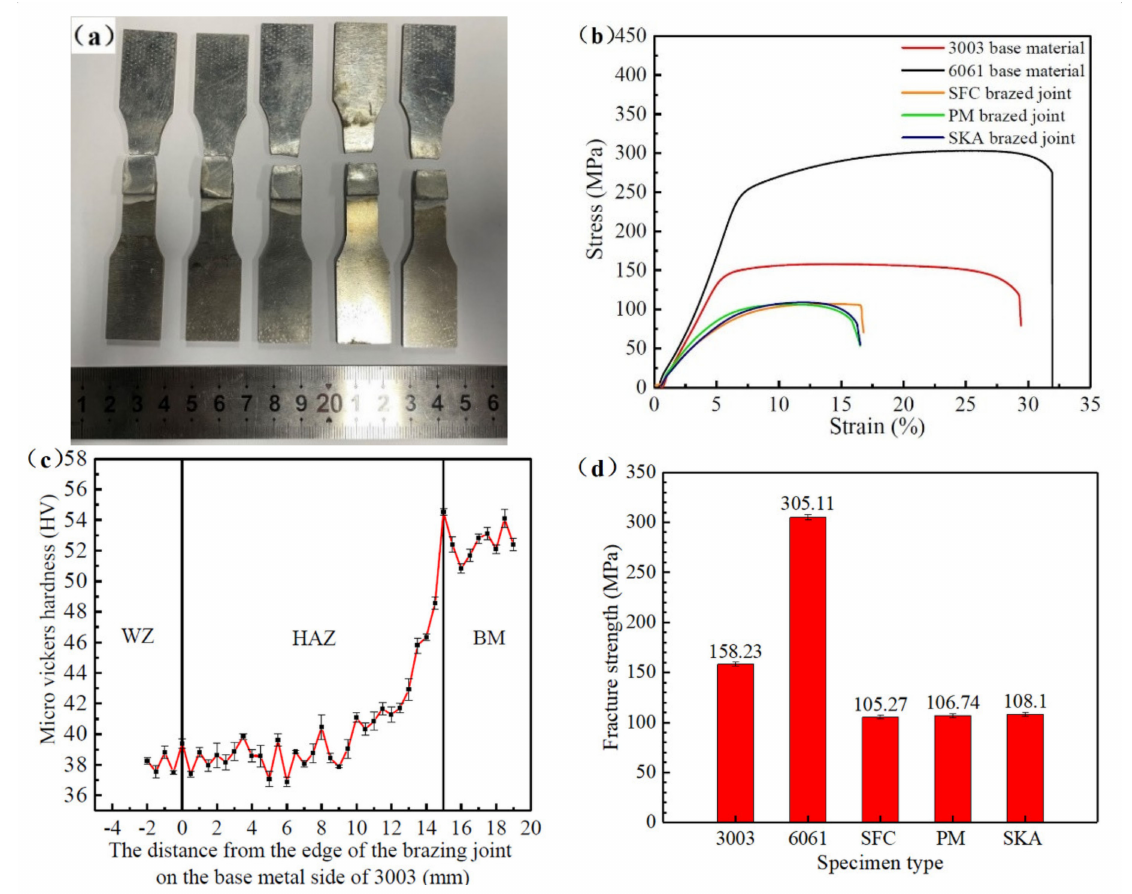
Figure 12. ( a ) Brazed joint specimen; ( b ) Stress-strain curve; ( c ) The micro Vickers hardness of the brazing joint on the base metal side of 3003. ( d ) Mechanical